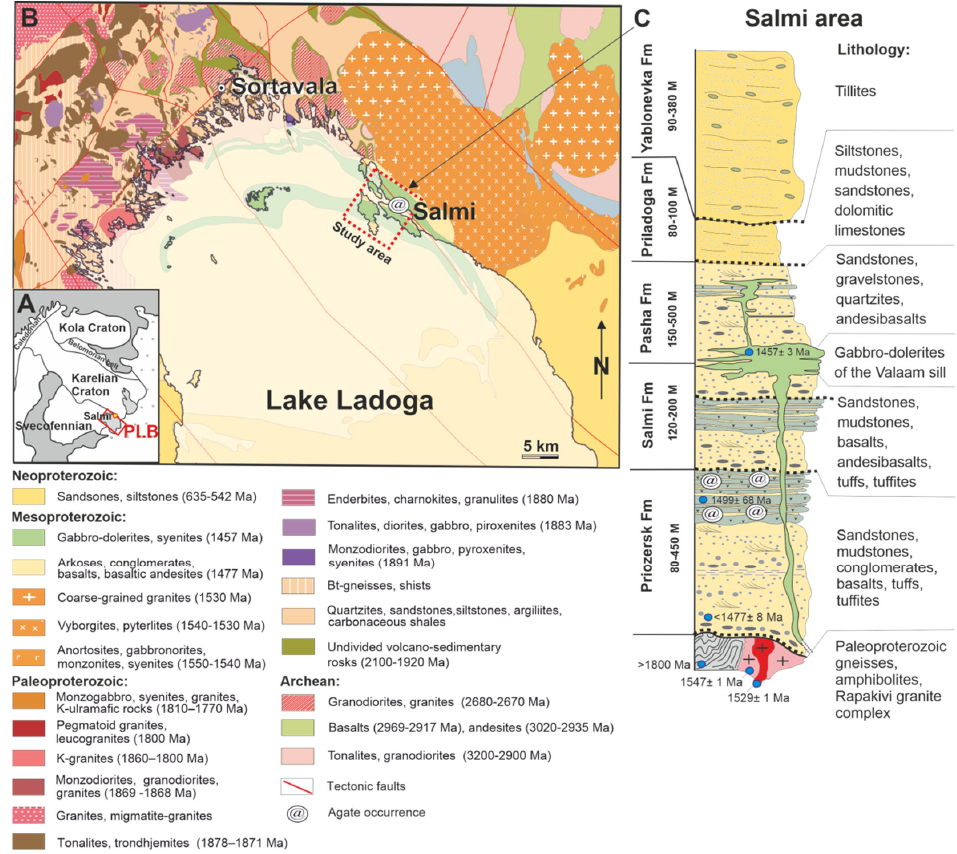
Figure 1. ( A ) Location of sampling areas. ( B ) simplified geological map of the Pasha–Ladoga Basin based on [18]. ( C ) simplified geological section of the studied area based on [12], [17] (pp. 49–50). Dotted line marks position of weathered crusts or erosion rock layers; @ represents sampled agate-bearing flows.